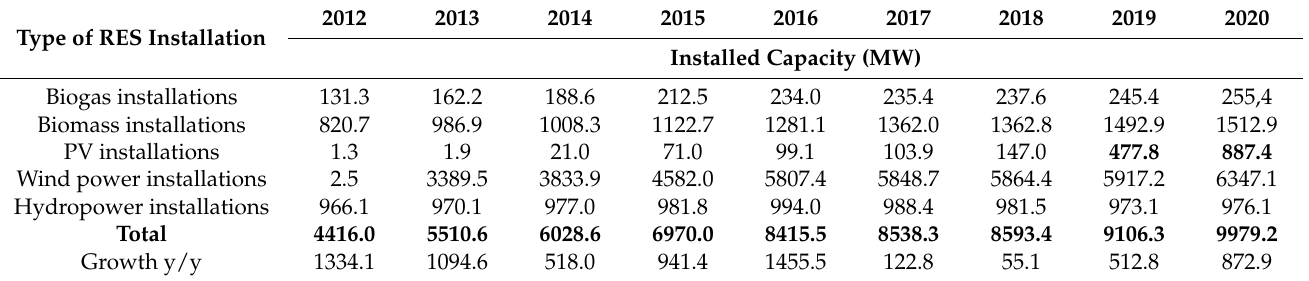
Table 5. The installed capacity of the renewable energy generation sector in Poland in 2012–2020 by type of energy installations that hold a licence or are entered in the register of energy sector